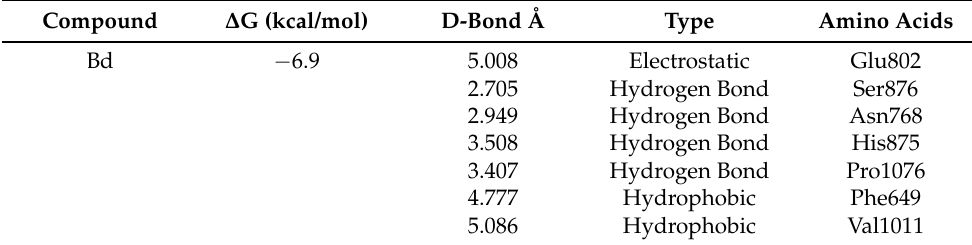
Table 6. Docking results of binding of Bd to active site of xanthine